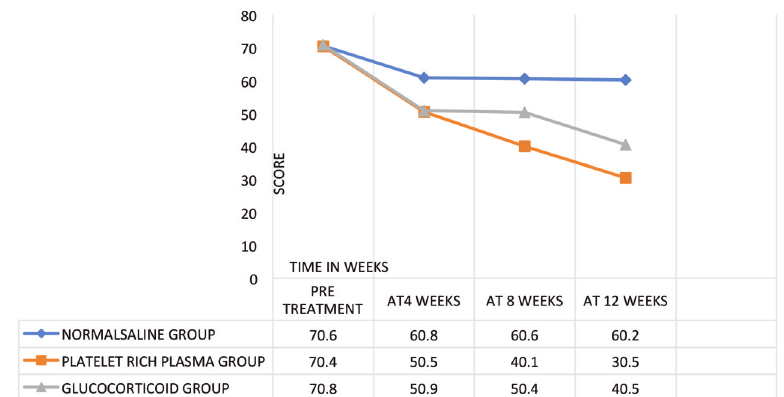
Comparison of VAS score, (pre -treatment and post infiltration of normal saline, l-PRP, glucocorticoid at follow-up visits of 4, 8, Fig. 3: and 12 weeks).